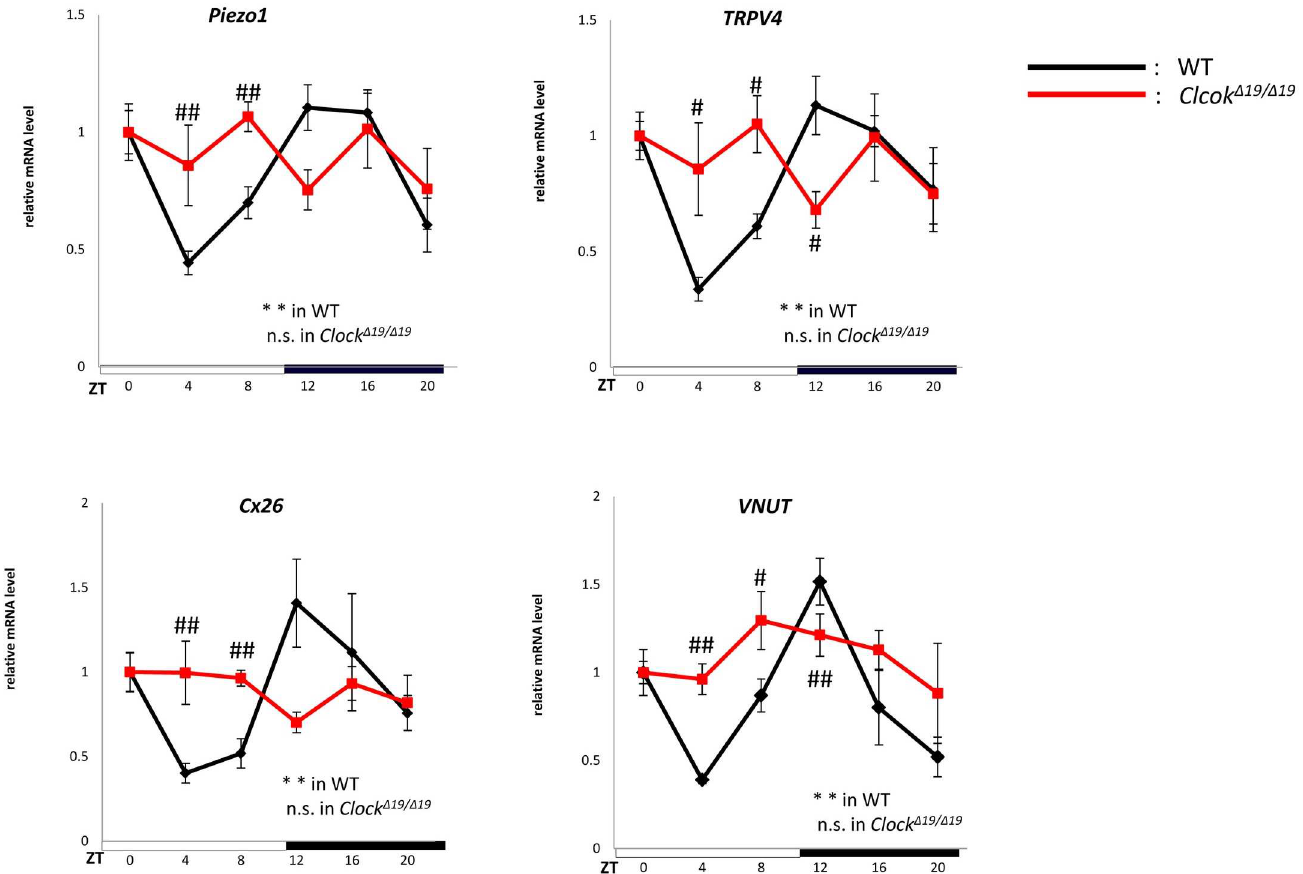
Fig 2. Time-dependent changes in mechanosensor, Cx26 and VNUT mRNA expression in the mouse bladder mucosa. Mechanosensor, Cx26 and VNUT mRNA expressionrhythms in the mouse bladder mucosa in WT and Clock Δ 19/ Δ 19 mice under a 12-h light/dark cycle. N = 4 for WT mice, N = 4 for Clock Δ 19/ Δ 19 mice at each point. Statistical analyseswere performed using a one-wayANOVA to compare differences amongtime points in each group. * P < 0.05, ** P < 0.01, n.s., not significant.Data are presented as means ± SE. ZT0 was normalized as 1 independently in each genotype. Using S2 Fig, a two-way ANOVA and Bonferroni’s test was used to comparedifferences of absolutemRNA level betweenWT and Clock Δ 19/ Δ 19 mice at each time point (S2 Fig). # P < 0.05, ## P <